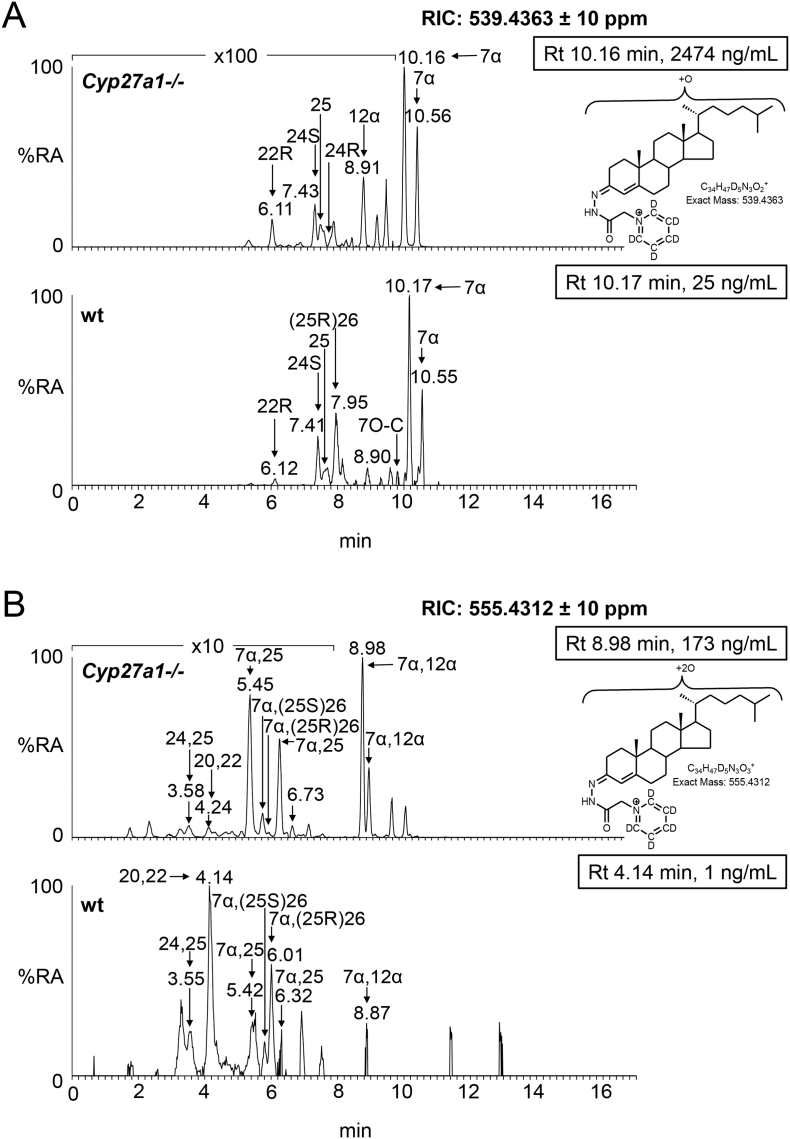
Oxysterols in Cyp27a1−/− and Cyp27a1+/+ (wt) mouse plasma. Each chromatogram is normalised to the most intense peak at 100% relative abundance (RA). Magnification factors are as indicated. The concentration of the indicated analyte (by retention time, Rt) is given in the right-hand corner of each chromatogram. Chromatograms from the oxysterol fractions treated with cholesterol oxidase (combination of sterols with a native 3-oxo group and those oxidised by cholesterol oxidase to contain a 3-oxo group) are shown. The insets show structures of generic GP derivatives. Many oxysterols elute as twin peaks corresponding to syn and anti conformers. (A) Monohydroxycholesterols and monohydroxycholest-4-en-3-ones. (B) Dihydroxycholesterols and dihydroxycholest-4-en-3-ones. (C) Trihydroxycholesterols and trihydroxycholest-4-en-3-ones. (D) 3β,24-Dihydroxycholest-5-ene-25-methoxide, the methanolysis product of 24S,25-epoxycholesterol. In (A-C) peaks are labelled with the location of the relevant hydroxy groups on the cholesterol or cholest-4-en-3-one structure. In (D) 3β,24-Dihydroxycholest-5-ene-25-methoxide is abbreviated to 24H,25 M.